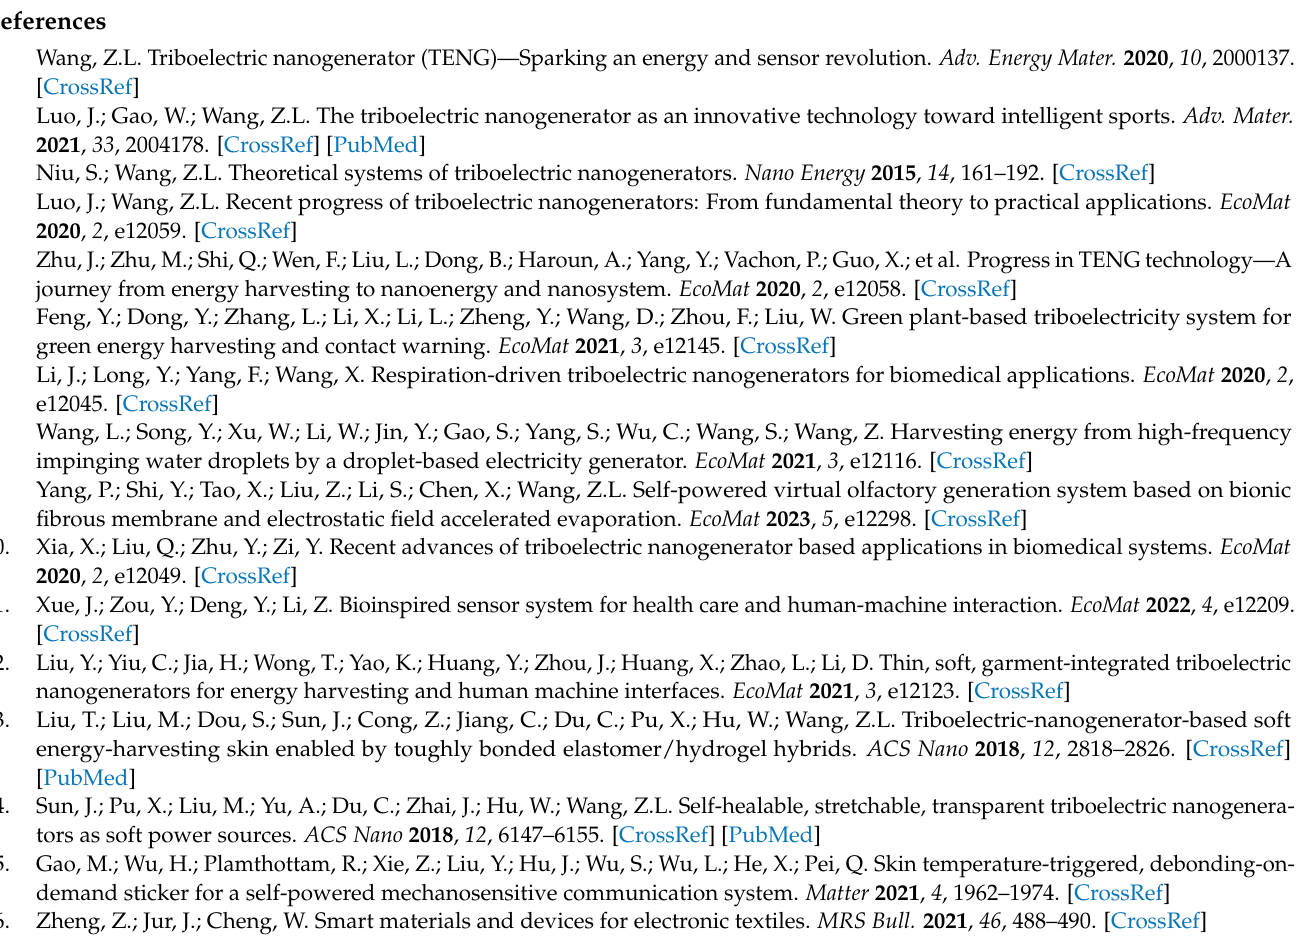
Figure A3. ( a , b ) The schematic diagrams showing ( a ) the uneven raised dots on the surface of an ordinary PET film, ( b ) pressure-sensitive adhesive applied to a PE film. ( c , d ) Microscopic images showing the top view of ( c ) the surface of a transparent PET film and ( d ) the adhesive applied to a transparent PE film.